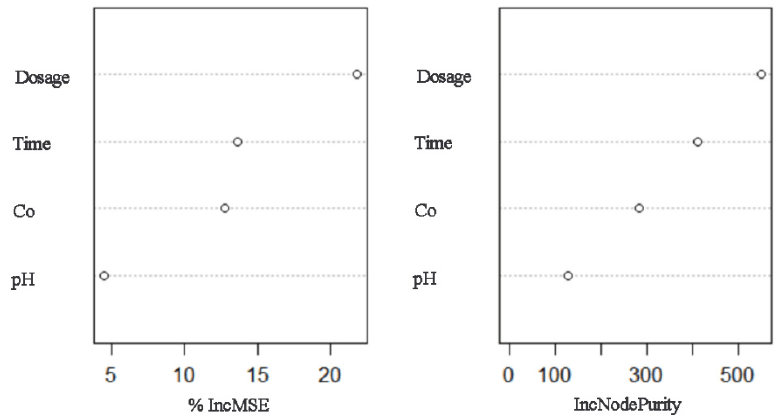
Figure 24. Feature importance for RF. Table 5. The weights and biases of input layers (wi and bi) and hidden layers (wj and bj).